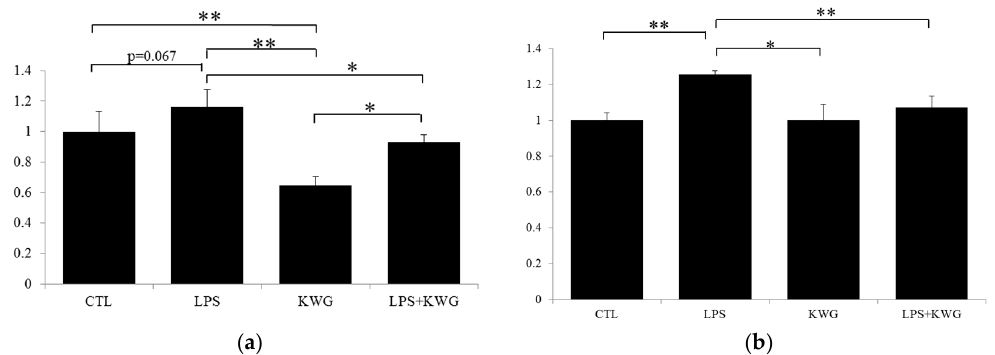
Figure 3. KWG decreased inflammatory cytokines’ expression in Caco-2 cells induced by LPS. Cells were treated with control (CTL), LPS, KWG or LPS + KWG for 24 h and the culture supernatant was collected. Inflammatory cytokines including ( a ) interleukin (IL)-1 β and ( b ) tumor necrosis factor (TNF)- α were analyzed by ELISA kit according to the manufacturer’s instructions. * p < 0.05; ** p < 0.01.